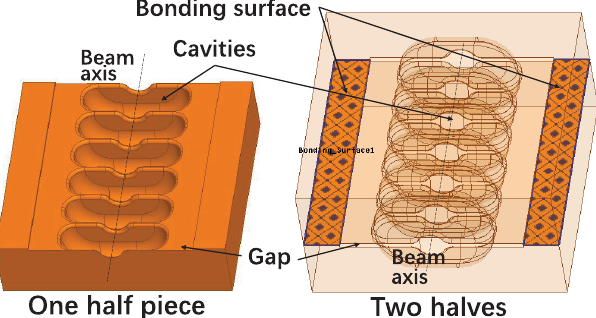
FIG. 2. Manufacturing accelerating structure by milling on two halves of copper plate (HFSS model